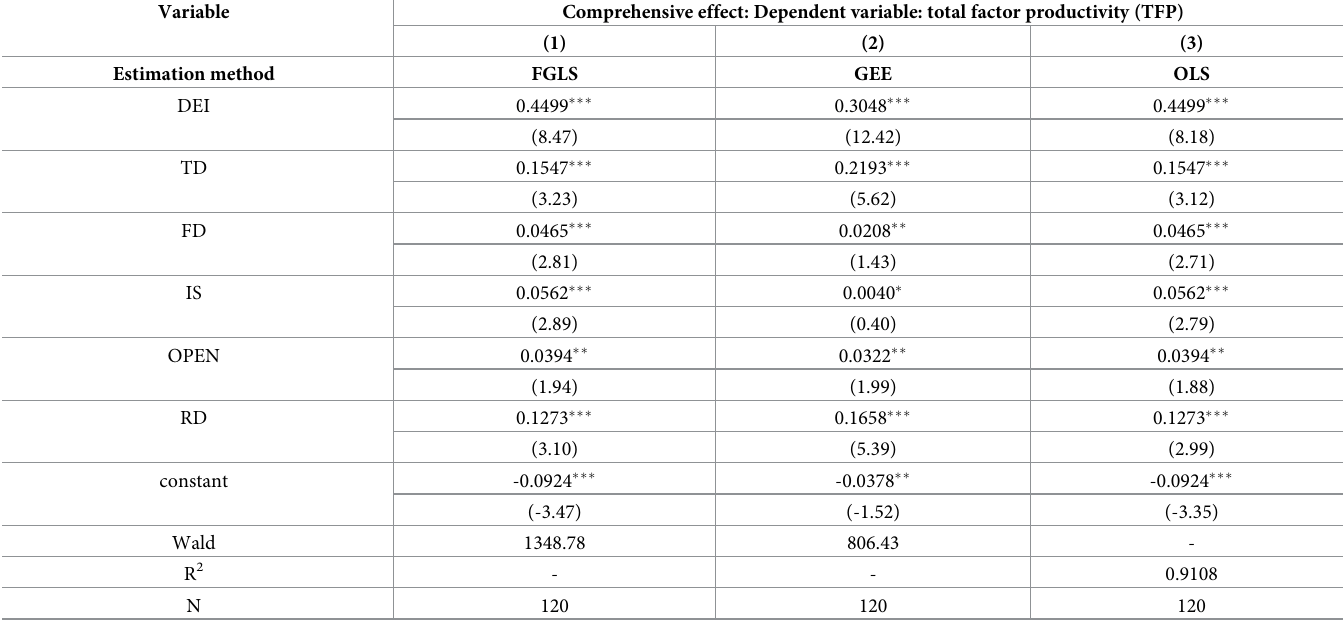
Table 12. Endogenous test results.